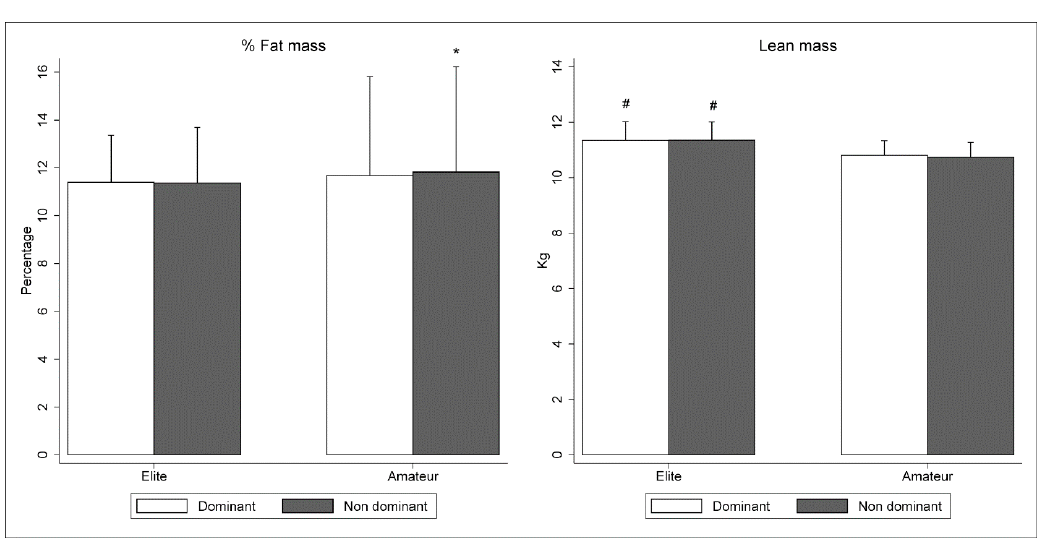
Figure 1. Fat mass percentage (%) and lean mass (kg) of both dominant leg and non-dominant leg of elite and sub-elite futsal players. # Significant differences between elite and sub-elite futsal players ( p < 0.05); * Significant differences between dominant and non-dominant lower limb.